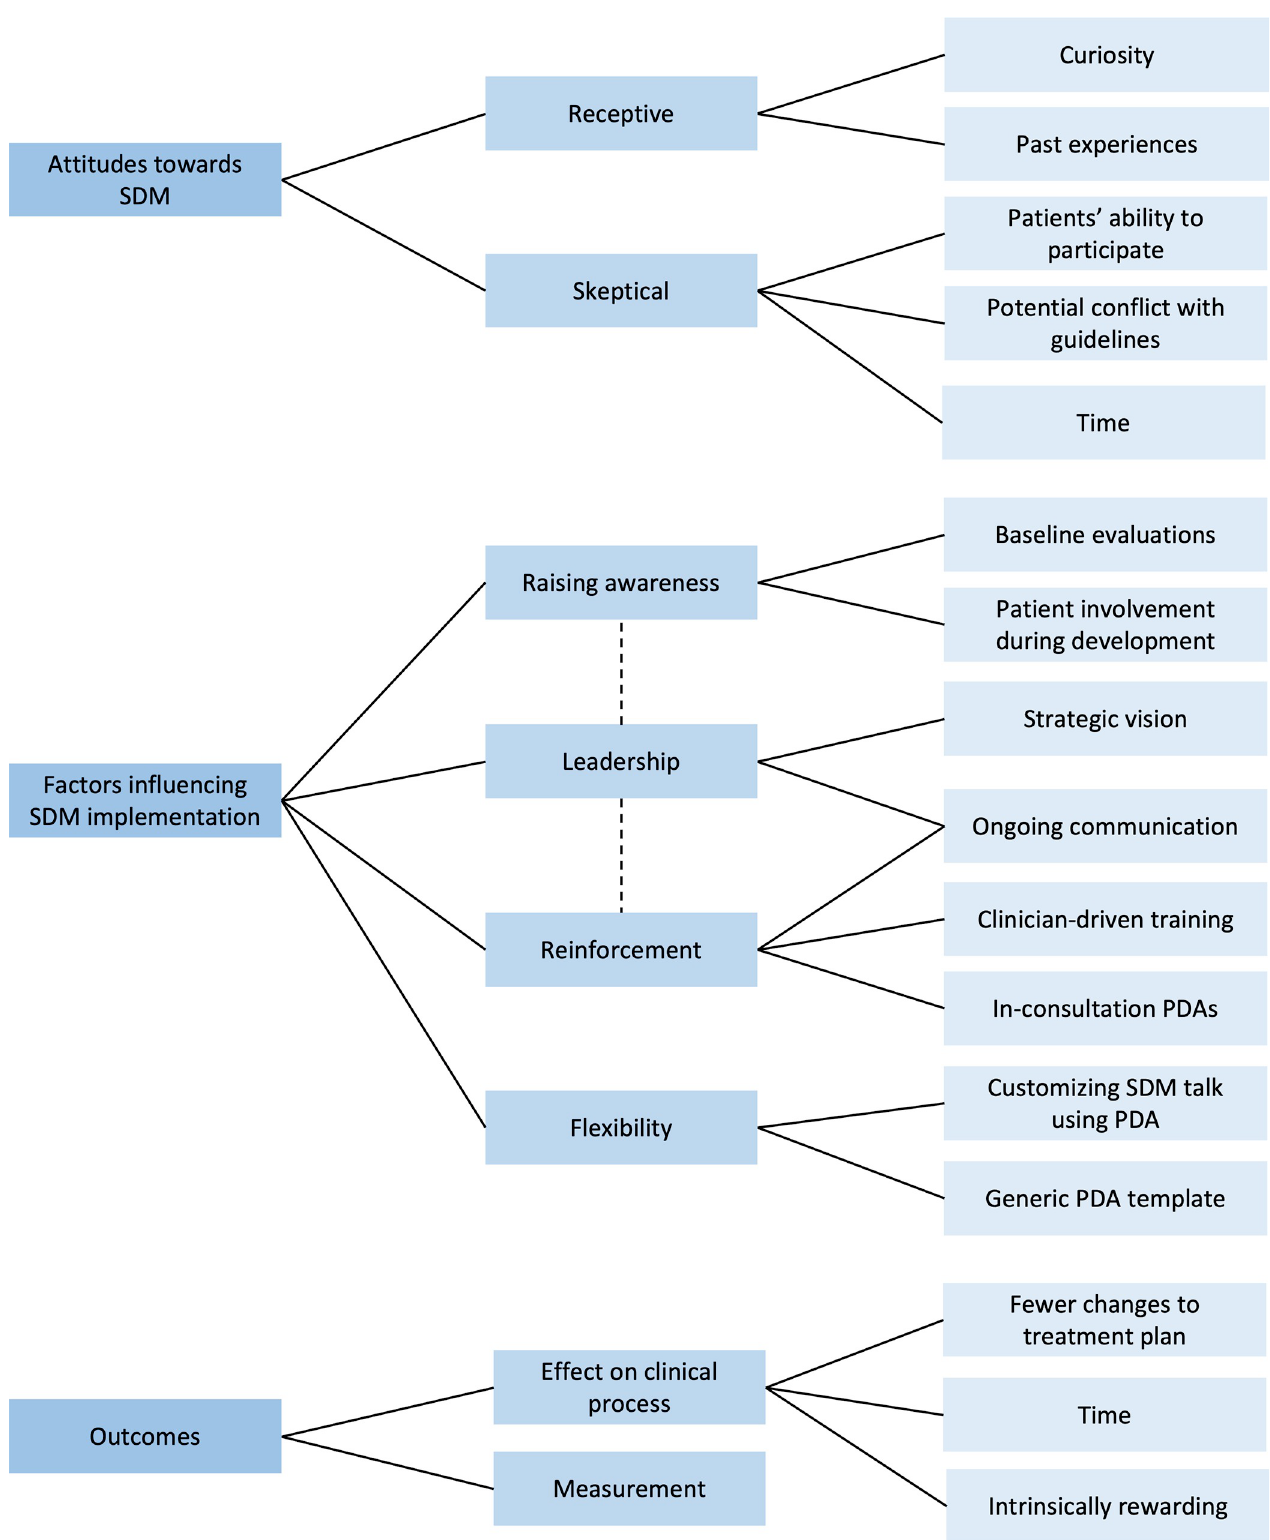
Fig 1. Thematic map of themes and subthemes for each research question. Solid lines indicate links between themes and subthemes, while dashed lines indicate relationships between themes.